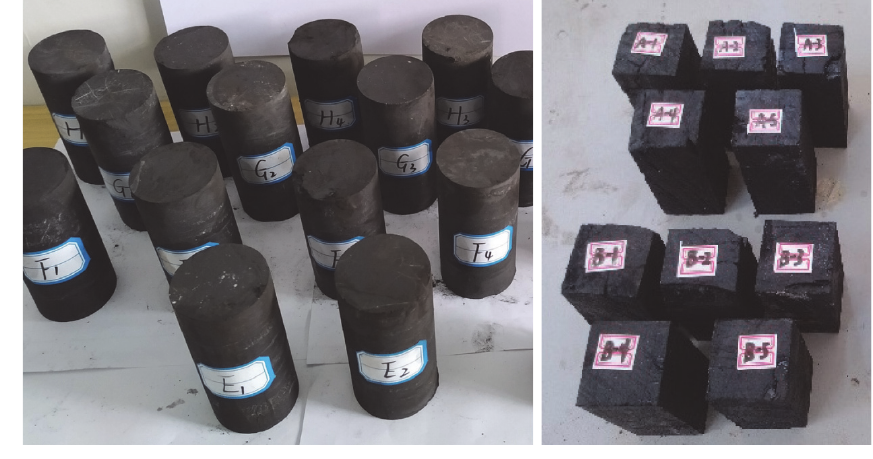
Figure 3: Coal samples.